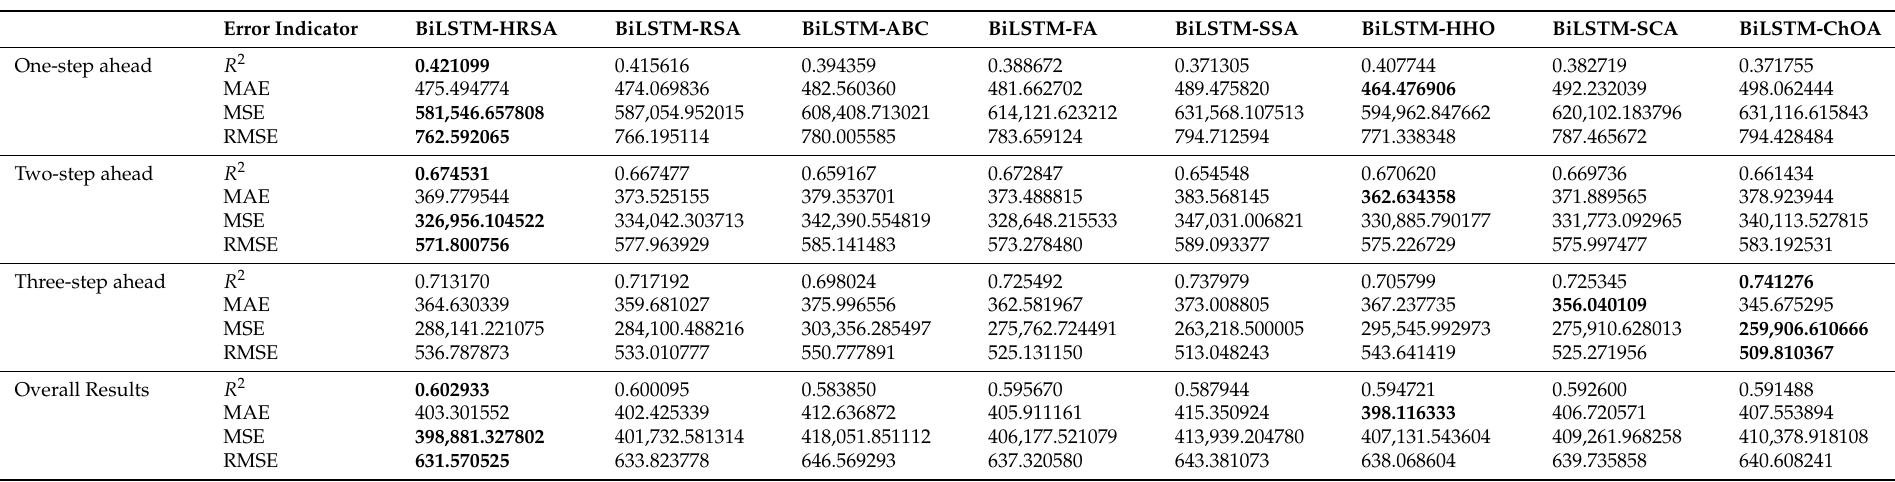
Table 7. Denormalized metrics for one-step, two-step, three-step ahead, and overall predictions for BiLSTM experiments. The best result in each column is written in